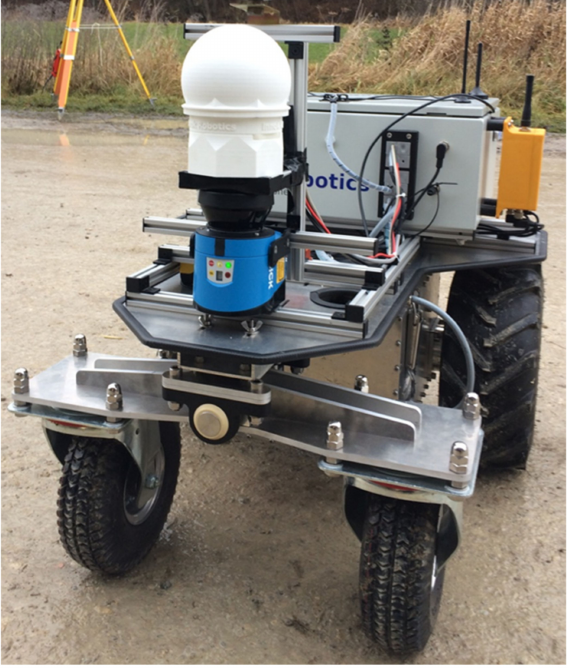
Figure 4. The robot vehicle with a laser scanner (blue-black) and radar scanner in the early prototype stage (white). (Own